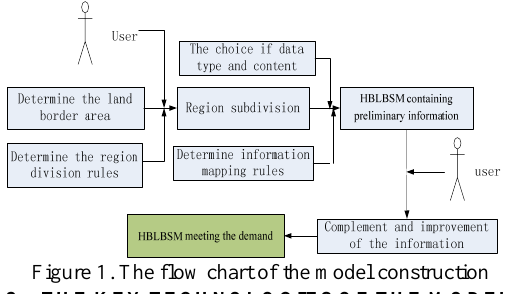
Figure 1. The flow chart of the model construction